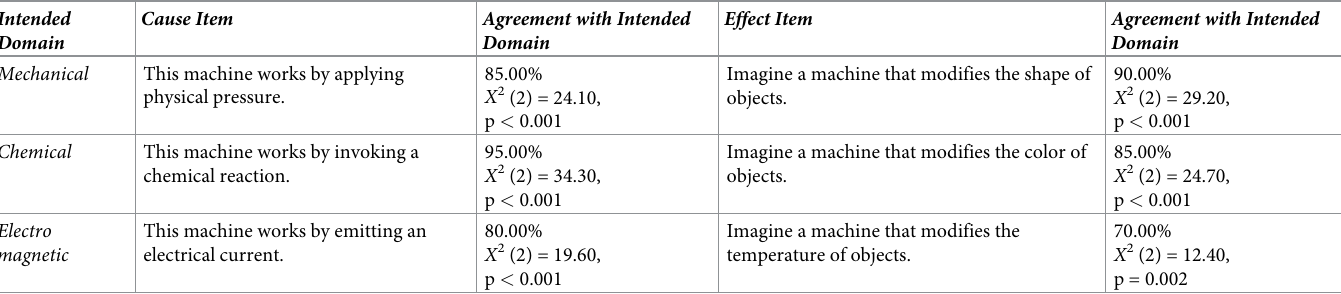
Table 2. Normed stimuli used in Studies 2a and 2b, alongside judged domain and chi-square tests for the three causes and the three effects in Studies 2a and